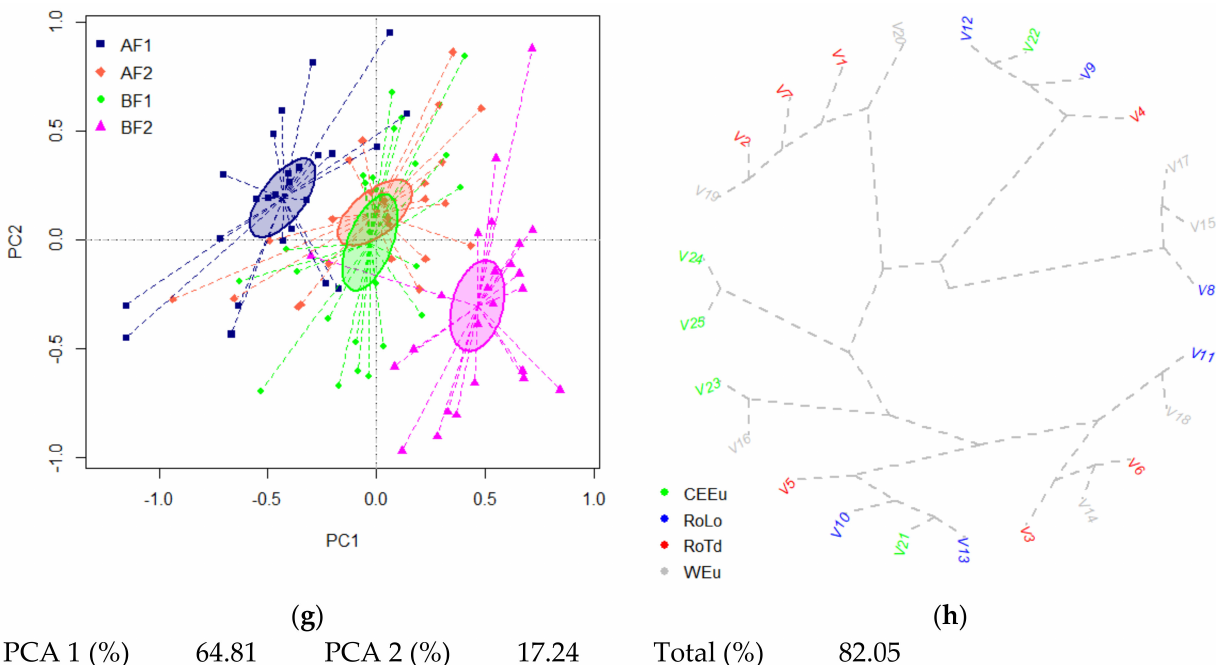
Figure 2. PCA and cluster analysis of single-year and inter-annual profile for spring oat. Each point comprises the recorded values of yield in each of the three experimental years ( a , b –2015, c , d –2016, e , f –2017) and all three experimental years ( g , h ), separated by the combination Density x Fertilization. Explained variance (%) is provide separately for each PCA axis. Ellipses represent the standard error within each group in a confidence interval of 95%. Density of sowing: A = 12.5 cm; B = 25.0 cm. Fertilization: F1 = N 100 P 50 ; F1 = N 50 P 50 . V1—Some¸san; V2–Mure¸s; V3–Mure¸sana; V4–T. 90-81 M; V5–T. 21-81 M; V6–T. 38-81 M; V7–T. 44-81 M; V8–LV. 4324-86; V9–LV. 4325-86; V10–LV. 4362-86; V11–LV. 4363-86; V12–LV. 8644-82; V13–LV. 7478-82; V14–Solidor; V15–Romulus; V16–Gramena; V17–Jumbo; V18–Cory; V19–Avalanche; V20–Integrale; V21–Rumak; V22–Bug; V23–Skakum; V24–Fucs; V25–Pan. Full description of varieties is provided in Table